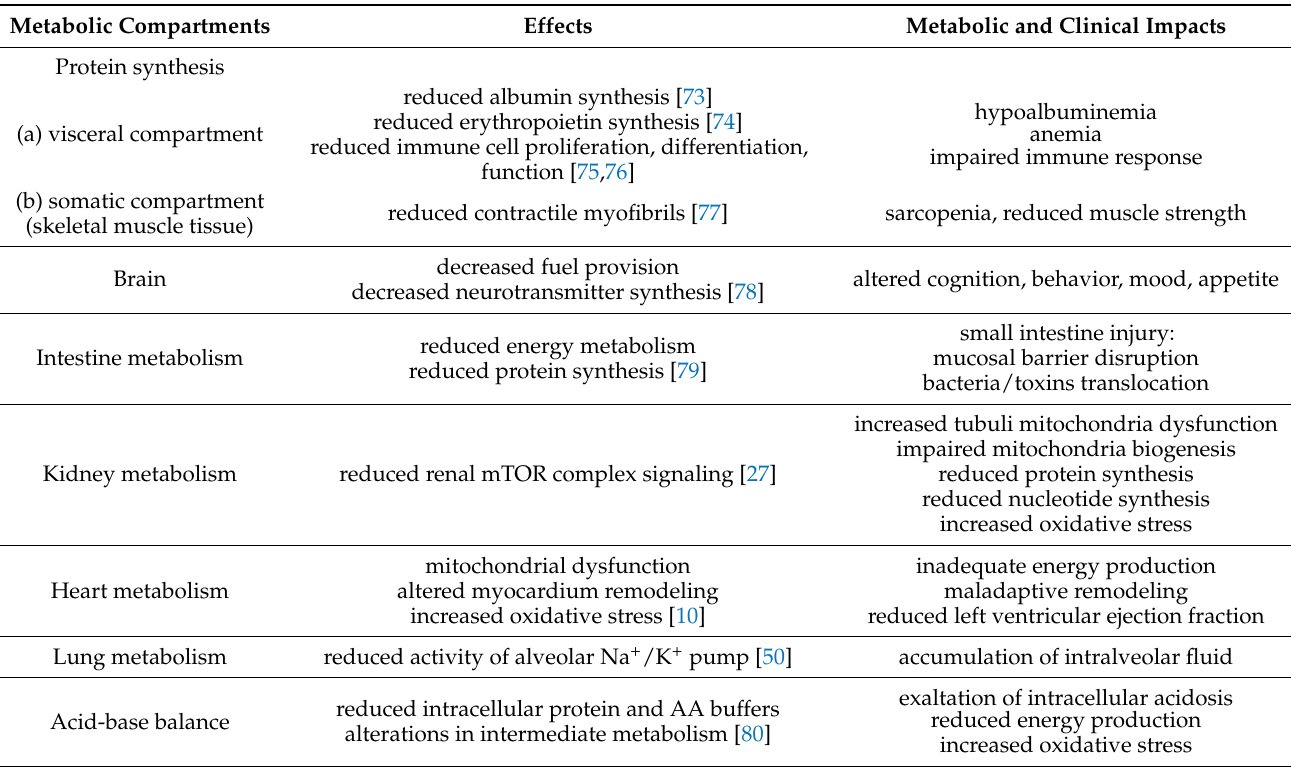
Table 11. Some examples of potential additive damage to altered physiology of CRS 2 patients from hypoaminoacidemia. Metabolic Compartments Protein